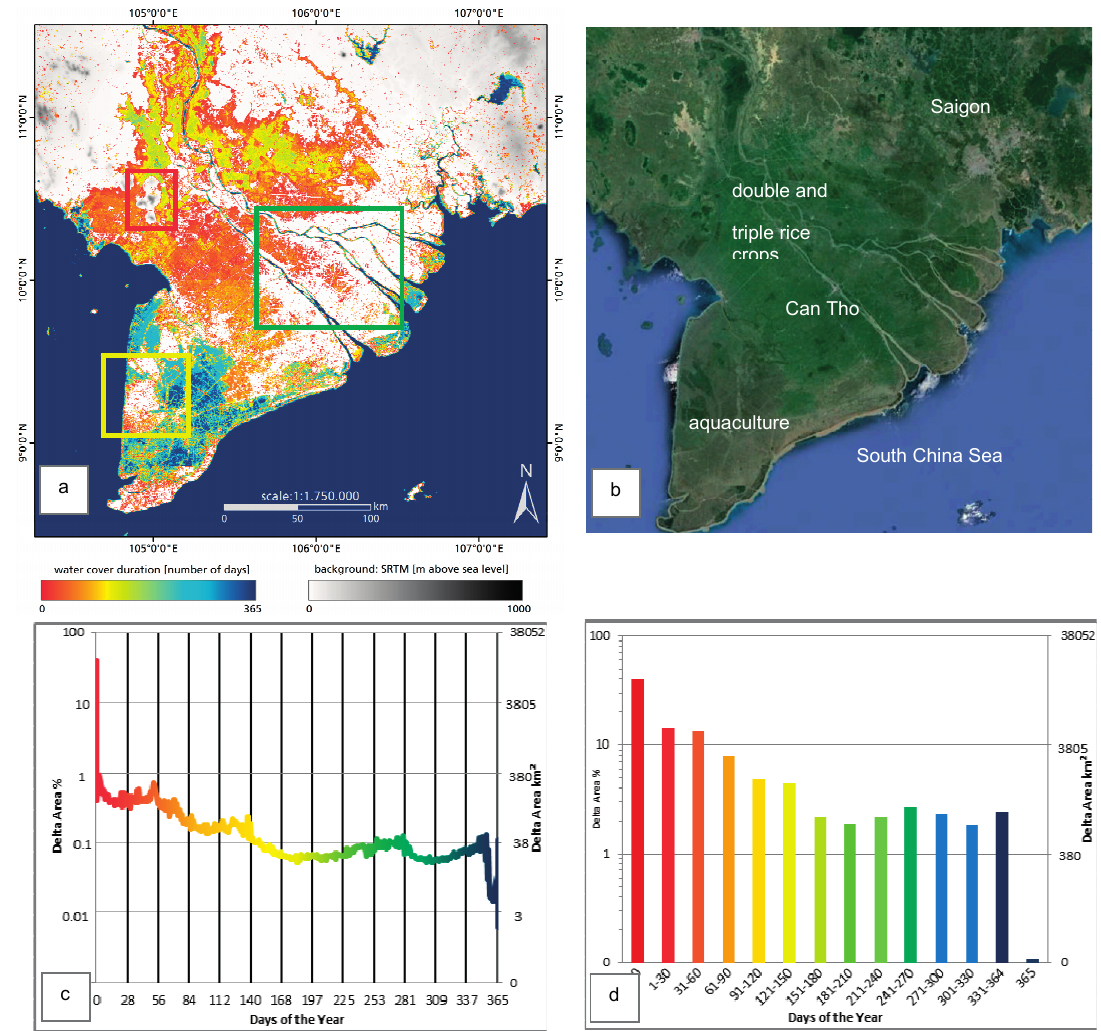
Figure 4. Intra-annual inundation patterns of the Mekong Delta, Vietnam, derived from an annual time series of daily temporal resolution for the year 2013. ( a ) intra-annual inundation dynamics, ( b ) optical data for comparison, ( c , d ) quantitative analyses of inundation